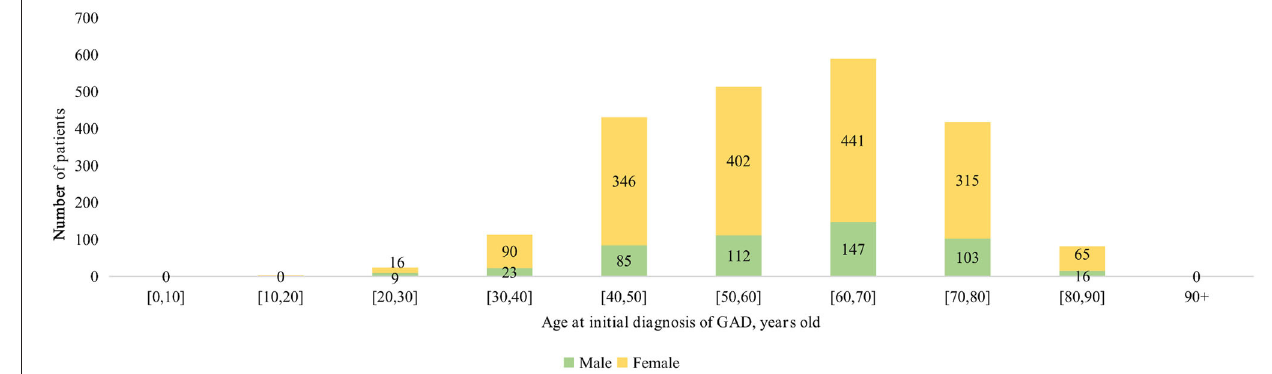
FIGURE 1 | Age-specific incidence of anxiety among male and female subgroups.